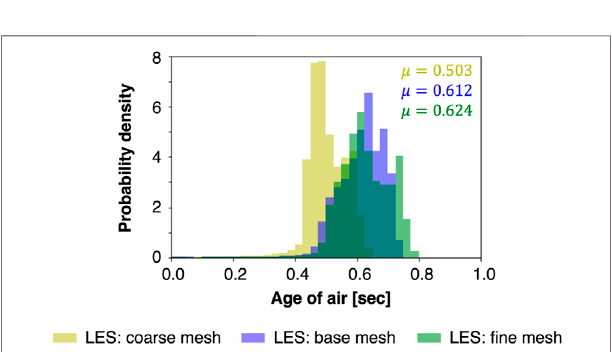
FIGURE 8 | Frequency distribution of age of air using the coarse, base, and fi ne meshes.